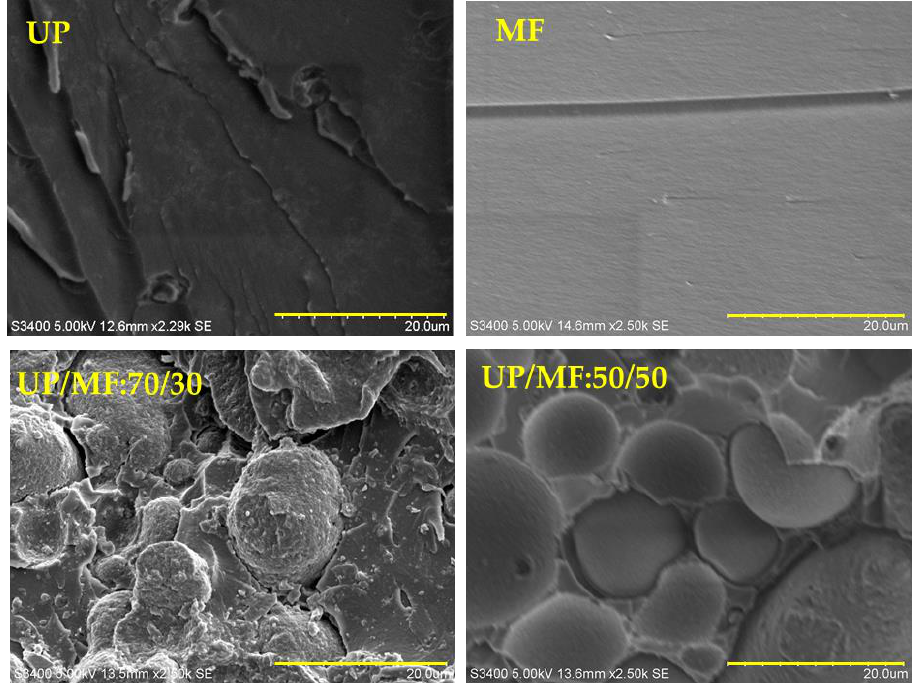
Figure 4. SEM images of fractured surfaces of UP, MF, UP/MF:70/30, and UP/MF:50/50 cured resin.